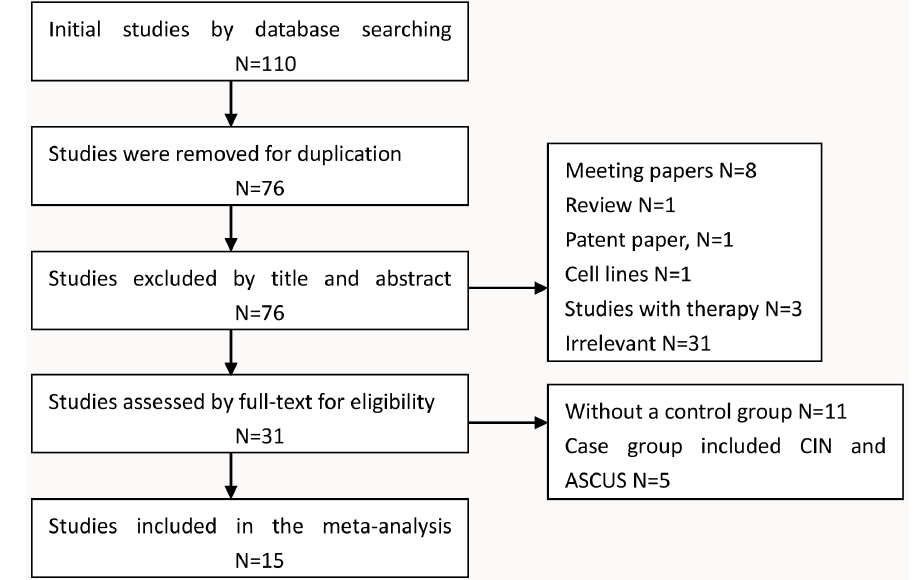
Figure 1. Flow chart of study selection for the meta-analysis.